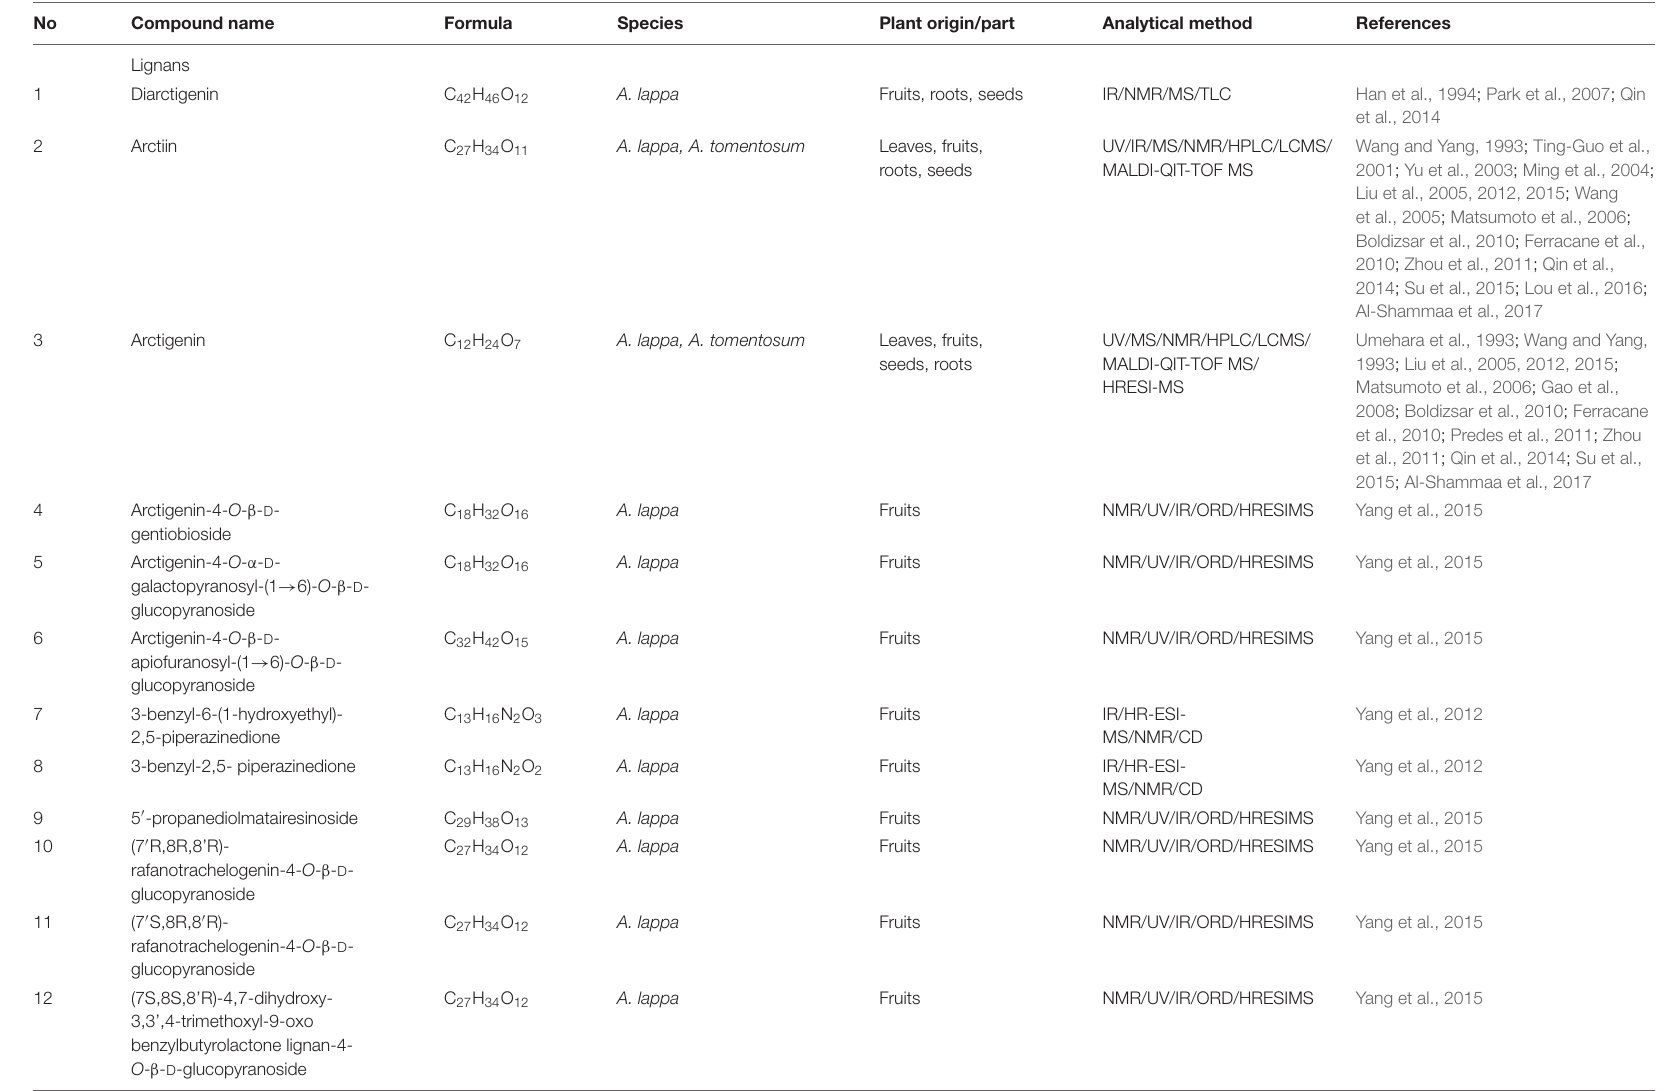
TABLE 1 | The known non-volatile constituents of Arctium